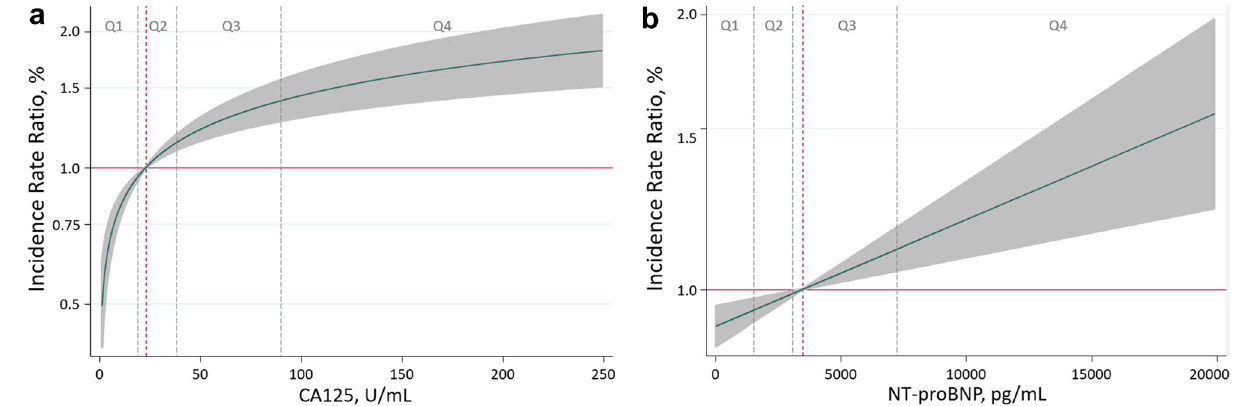
Figure 4. Functional form of the risk of all-cause mortality among the continuum of CA125 and NT-proBNP values. ( a ) CA125. ( b ) NT-proBNP. CA125: carbohydrate antigen 125; NT-proBNP: amino-terminal pro- brain natriuretic peptide. CA125 quartiles: Q1 = 1.4–19 U/mL; Q2 = 19–38.26 U/mL; Q3 = 38.3–90 U/mL; Q4 = 90–1500 U/mL. NT-proBNP quartiles: Q1 = 24–1589 pg/mL; Q2 = 1590–2922 pg/mL; Q3 = 2924–5447 pg/ mL; Q4 = 5450–35,000